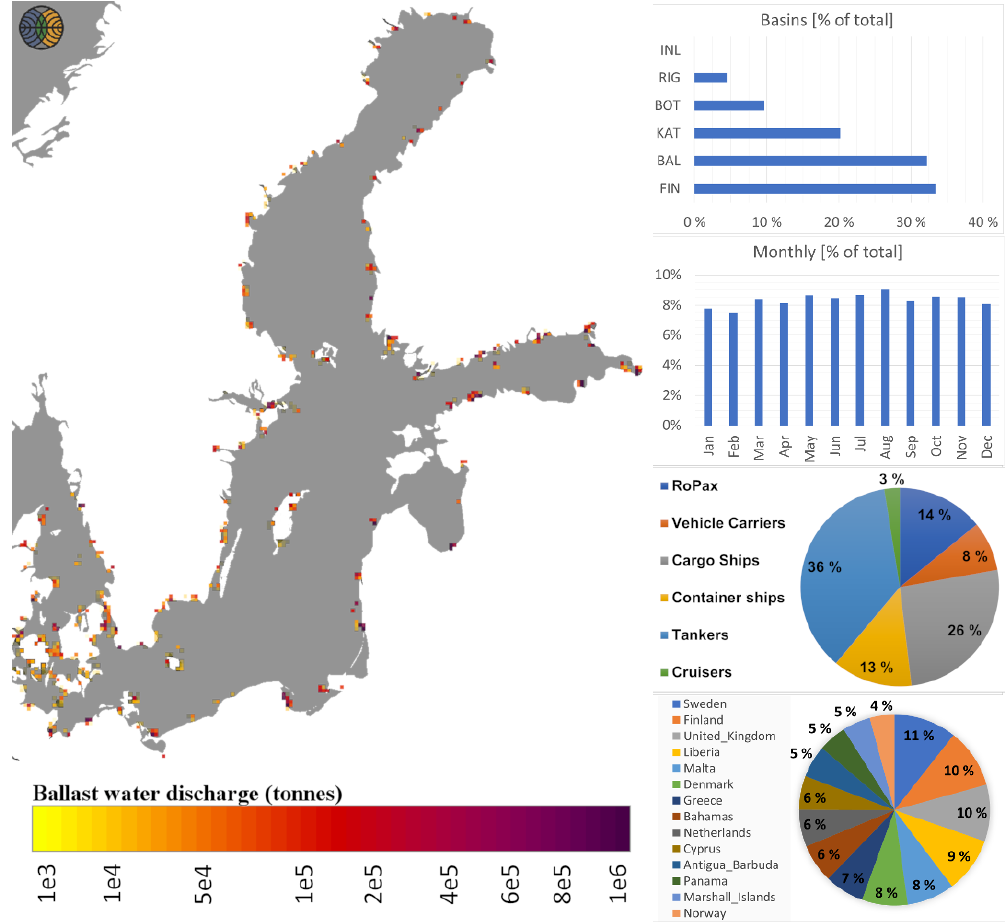
Figure 8. Distribution of the annual ballast water releases for the year 2012 from the Baltic Sea shipping. Discharge volumes are indicated in tonnes per map grid area of 40km 2 . Note the change in map resolution to highlight ballast water discharge locations on this map. Top right: share of ballast water released in various sub-basins of the Baltic Sea (INL: inland areas; RIG: Gulf of Riga; BOT: Bothnian Bay and Bothnian Sea; FIN: Gulf of Finland; KAT: Kattegat; BSP: Baltic Sea proper). The lower bar chart depicts the monthly variation in ballast water discharges. The upper pie chart summarises the contribution of various ship types to ballast water releases and the lower pie chart the flag state shares of ballast water releases. Map: background Landsat-8 image courtesy of the US Geological